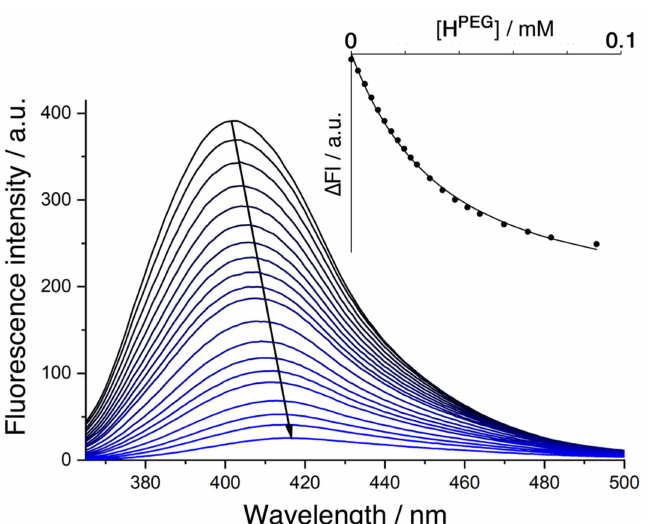
Figure 2. Fluorescence quenching of 4-methyl-7-aminocoumarin (10 − 5 M in CHCl 3 , 293 K) on the addition of increasing amounts of Co • H PEG (up to 9 equivalents); the calculated binding constant (see main text) arises from fitting the data to a 1:1 binding isotherm (inset, solid